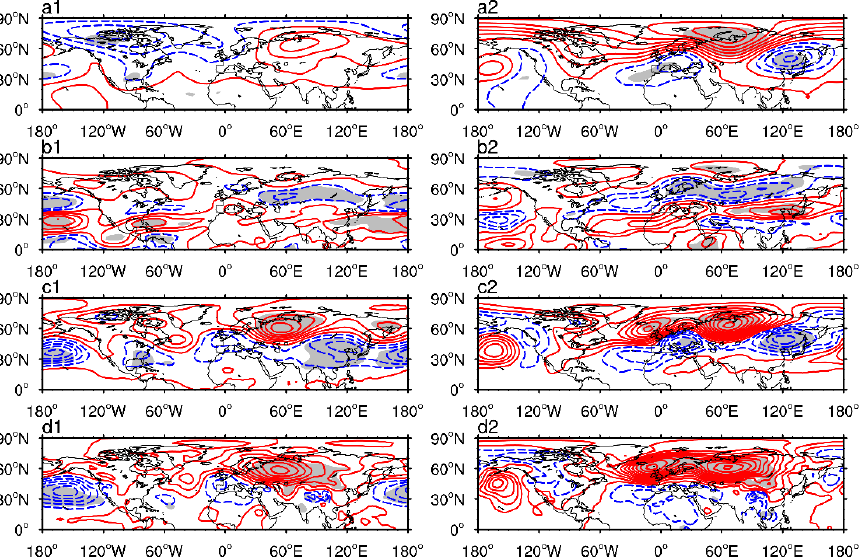
Figure 4. The linear regression of geopotential heights at 100 hPa (( a1 , a2 ), unit: gpm, contour interval: 10 gpm), zonal winds on 200 hPa (( b1 , b2 ), unit: m · s − 1 , contour interval: 1 m · s − 1 ), geopotential heights at 500 hPa (( c1 , c2 ), unit: gpm, contour interval: 5 gpm) and sea level pressure (( d1 , d2 ), unit: Pa, contour interval: 40 Pa) in winter against the comprehensive blocking indexes during P1 and P2. (The red lines represent that the regression coefficient is positive, and the blue is negative. The shaded area indicates that the regression coefficients have passed the significance test of 90%).